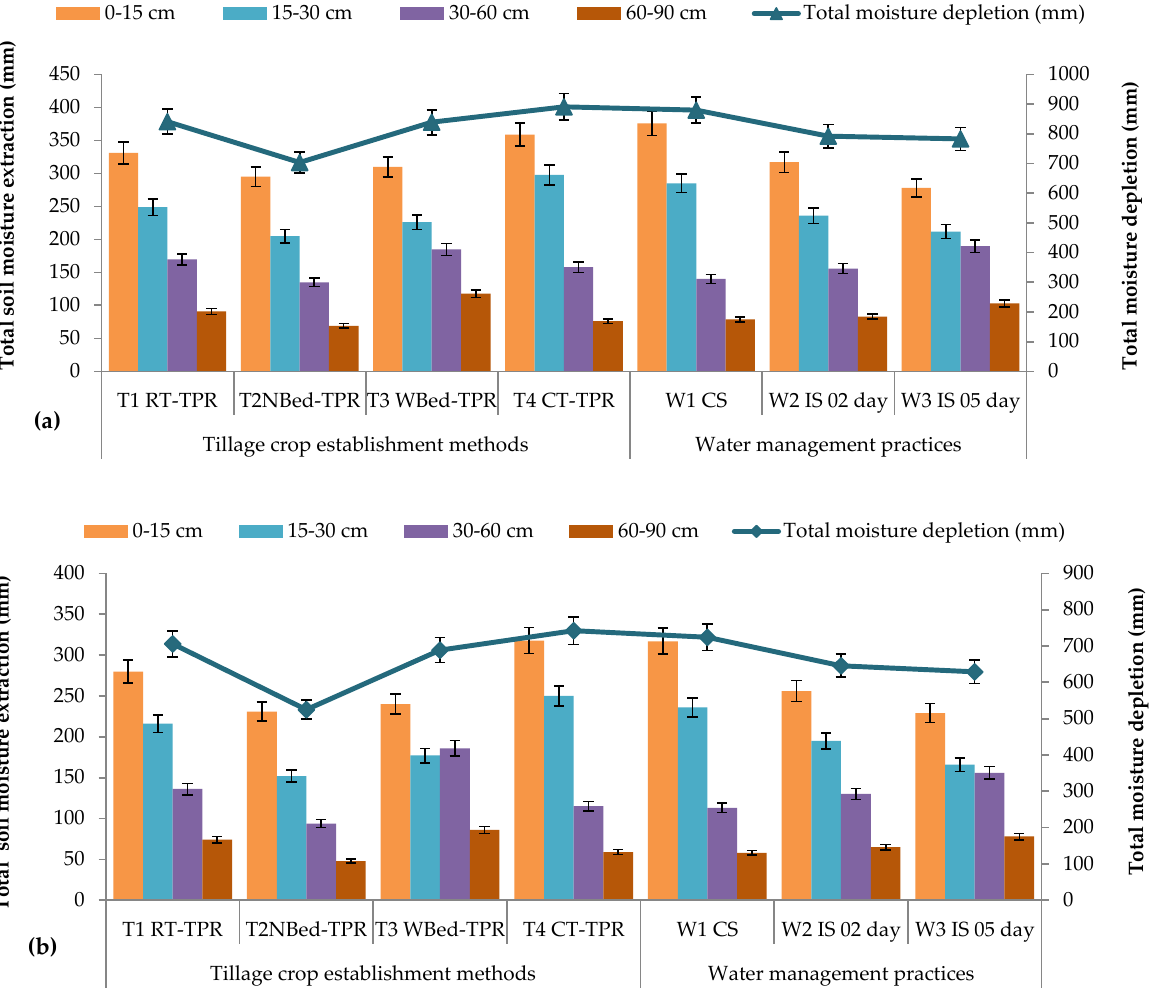
Figure 2. Tillage, water and nitrogen interactive effects on water extraction patterns in soil profile in both years: ( a ) 2016 and ( b ) 2017.